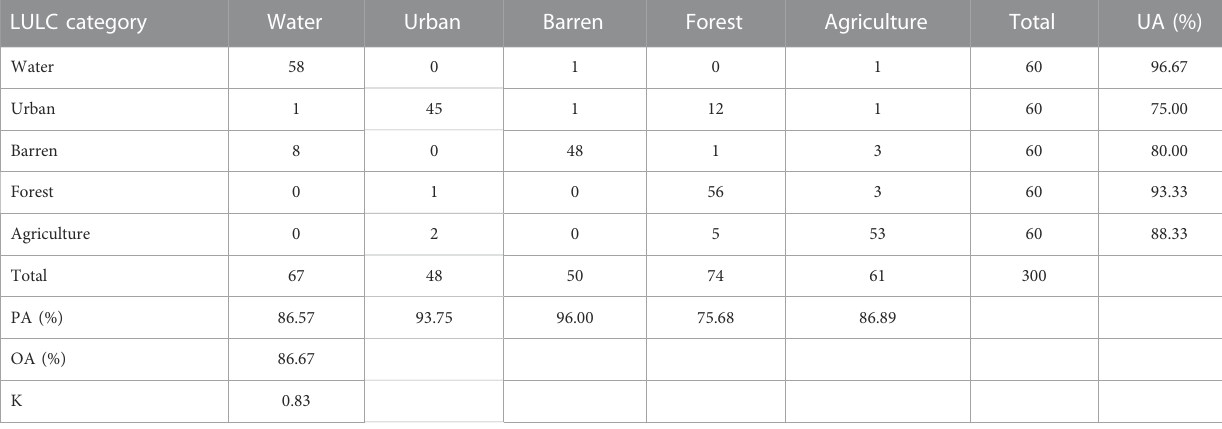
TABLE 2 Result of LULC accuracy assessment for the year